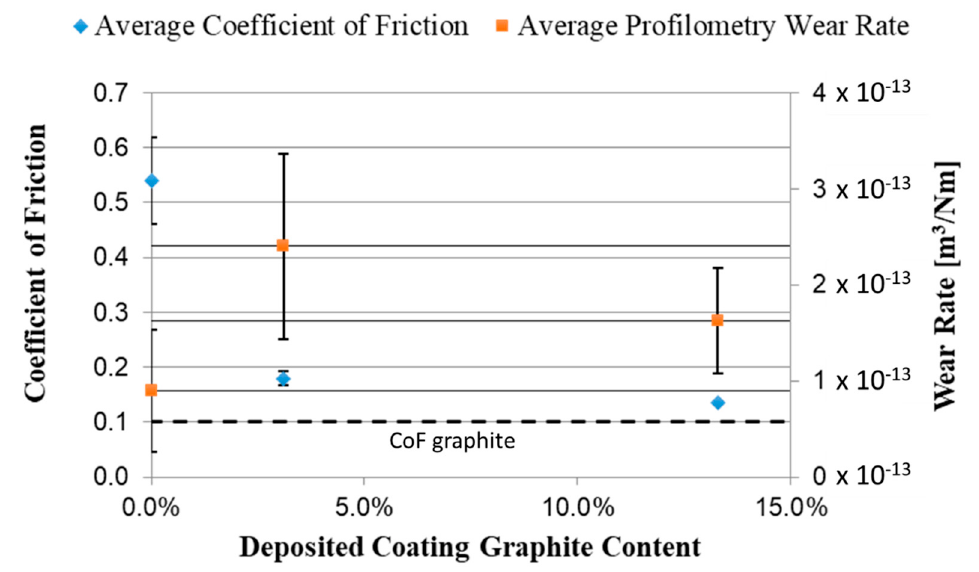
Figure 13. Friction and wear results plotted against graphite content. Error bars show the standard deviation for each measurement.